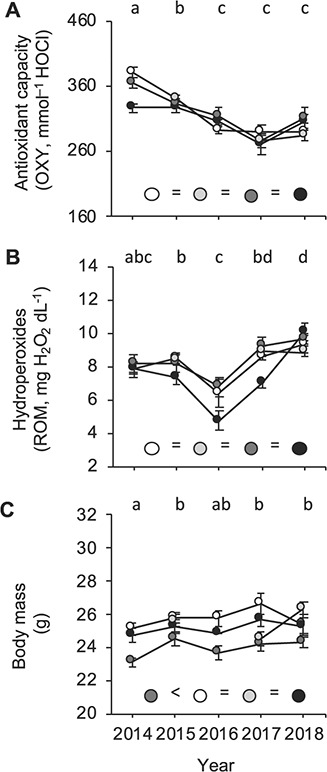
Plasma antioxidant capacity (OXY, mmol−1 HOCl; A), plasma hydroperoxides (ROM, mg H2O2 dL−1; B) and body mass (g; C), measured in early July each year from 2014 to 2018 in adult female M. myotis bats. Results are presented for each location where bats were captured (white: Férel; light grey: Béganne; dark grey: La Roche-Bernard; black: Noyal-Muzillac). Years with different letters at the top of each graph significantly differ and inter-colony differences irrespective of years are represented by coloured circles at the bottom of each graph. Results are presented as mean ± SE.